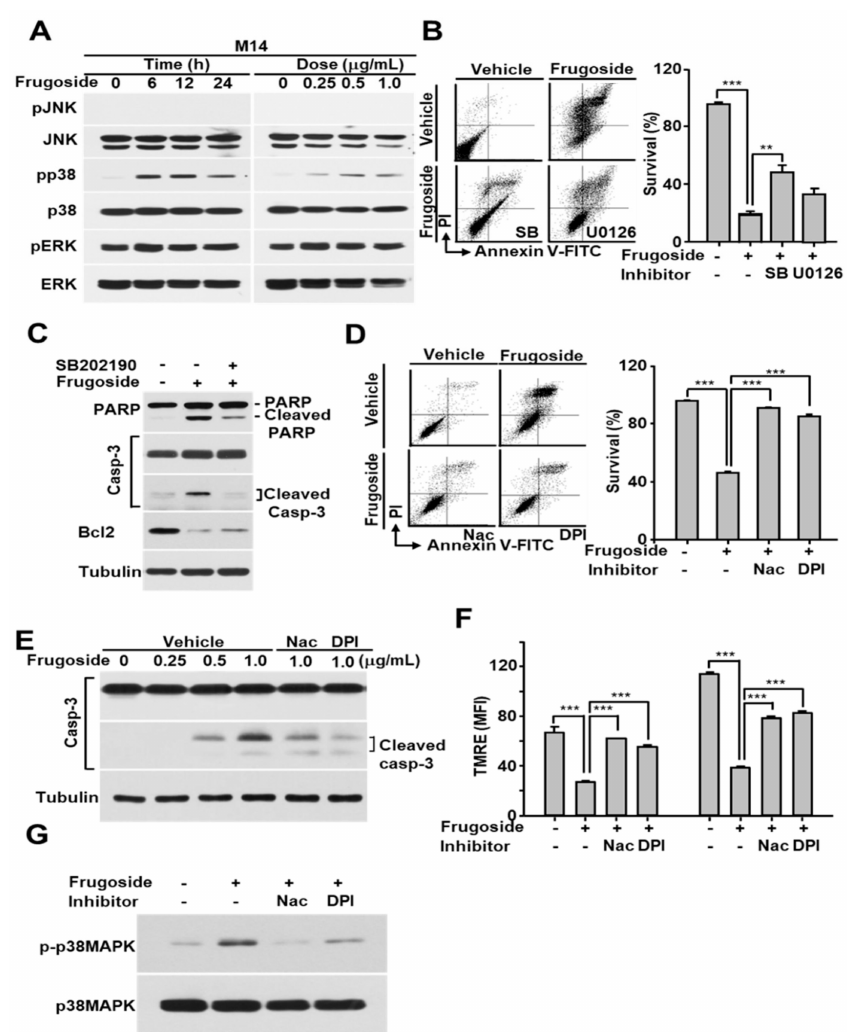
Figure 4. Frugoside-mediated ROS accumulation induces sustained p38 mitogen-activated protein kinase (MAPK) activation, and this activation contributes to apoptotic cell death. ( A ) M14 cells were treated with frugoside in time- and dose-dependent manners as described in Figure 3. The cell lysates were subjected to western blotting with antibodies specific to phosphorylated MAPKs as indicated. The same membrane was re-probed with antibodies to the following MAPKs: c-Jun N-terminal kinases (JNK), p38 MAPK, and extracellular signal-regulated kinase (ERK). ( B ) M14 cells were treated with 0.5 µ g / mL frugoside in the presence or absence of the p38 MAPK inhibitor, SB202190, or MAP / ERK kinase (MEK) 1 / 2 inhibitor, U0126, as indicated. The cells were analyzed for cell death using